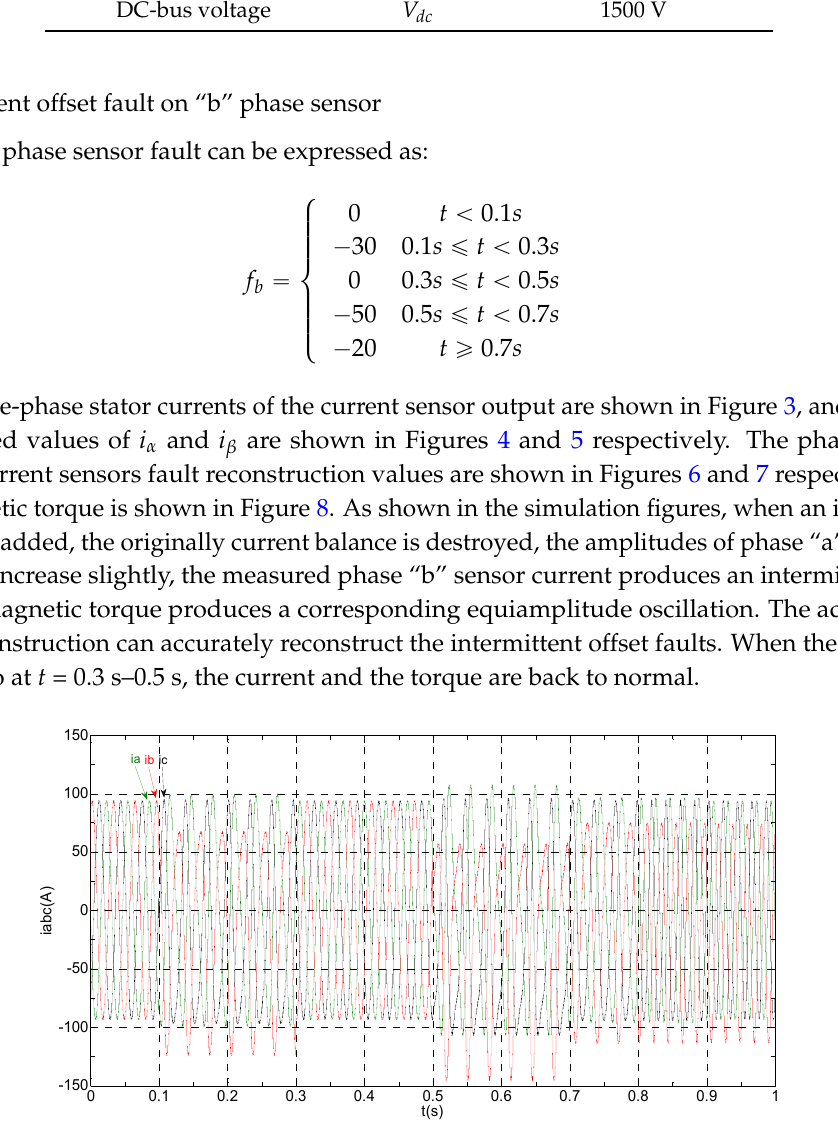
Figure 3. The measured value of the three-phase current.